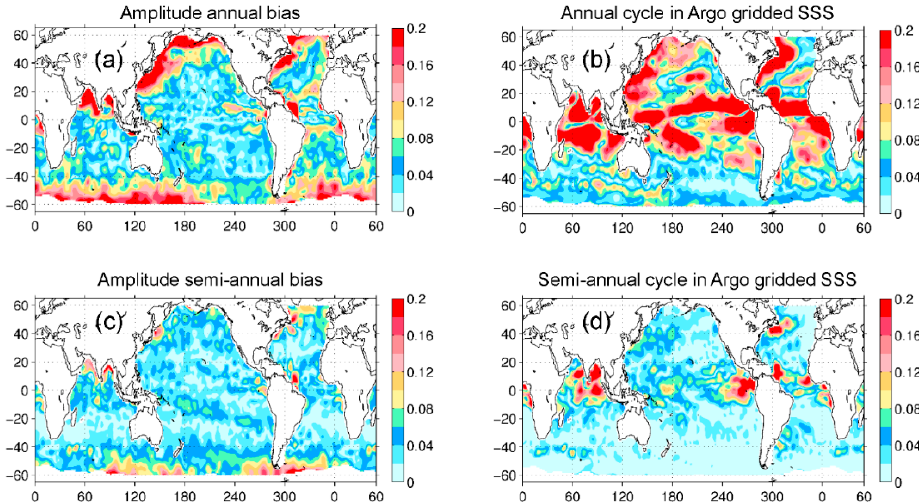
Figure 5. ( a ) Amplitude of the annual cycle in the Aquarius minus Argo bias; ( b ) Amplitude of the annual cycle in SSS from the Argo-derived gridded SSS fields produced by the Scripps Institution of Oceanography (SIO); ( c ) Amplitude of the semi-annual cycle in the Aquarius minus Argo bias; ( d ) Amplitude of the semi-annual cycle in SSS from the Argo-derived gridded SSS fields produced by the SIO.